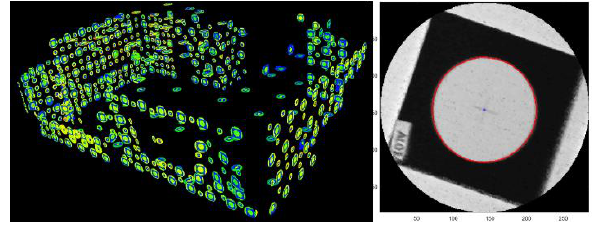
Figure 5. a) Left: Display of object space coordinate survey using laser scan data b) Right: close up of laser scanned targets centre being determined in the laser scan data.